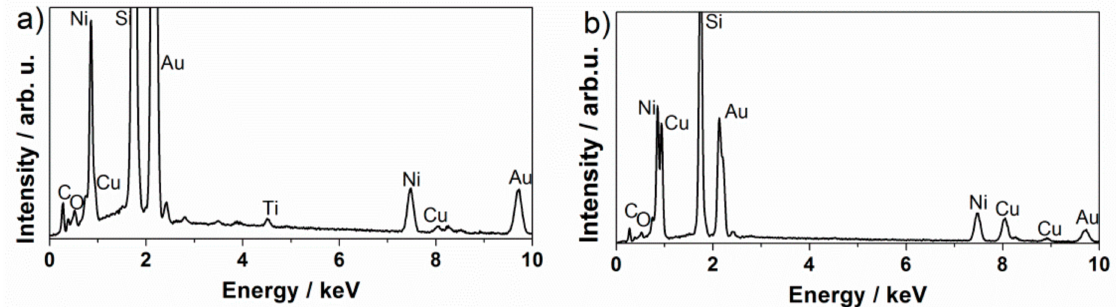
Figure 3. EDX spectra of the surface-mesostructured films with composition ( a ) Cu 20 Ni 80 and ( b ) Cu 45 Ni 55 .